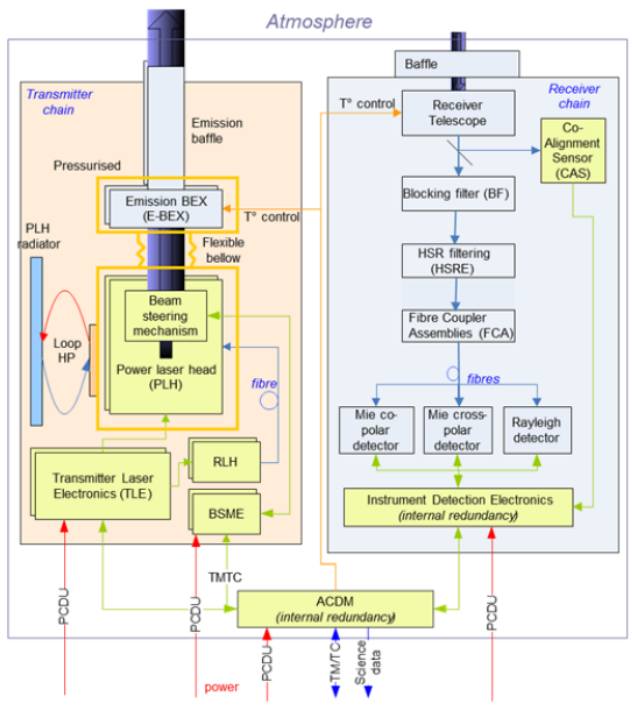
Figure 5. ATLID functional architecture.